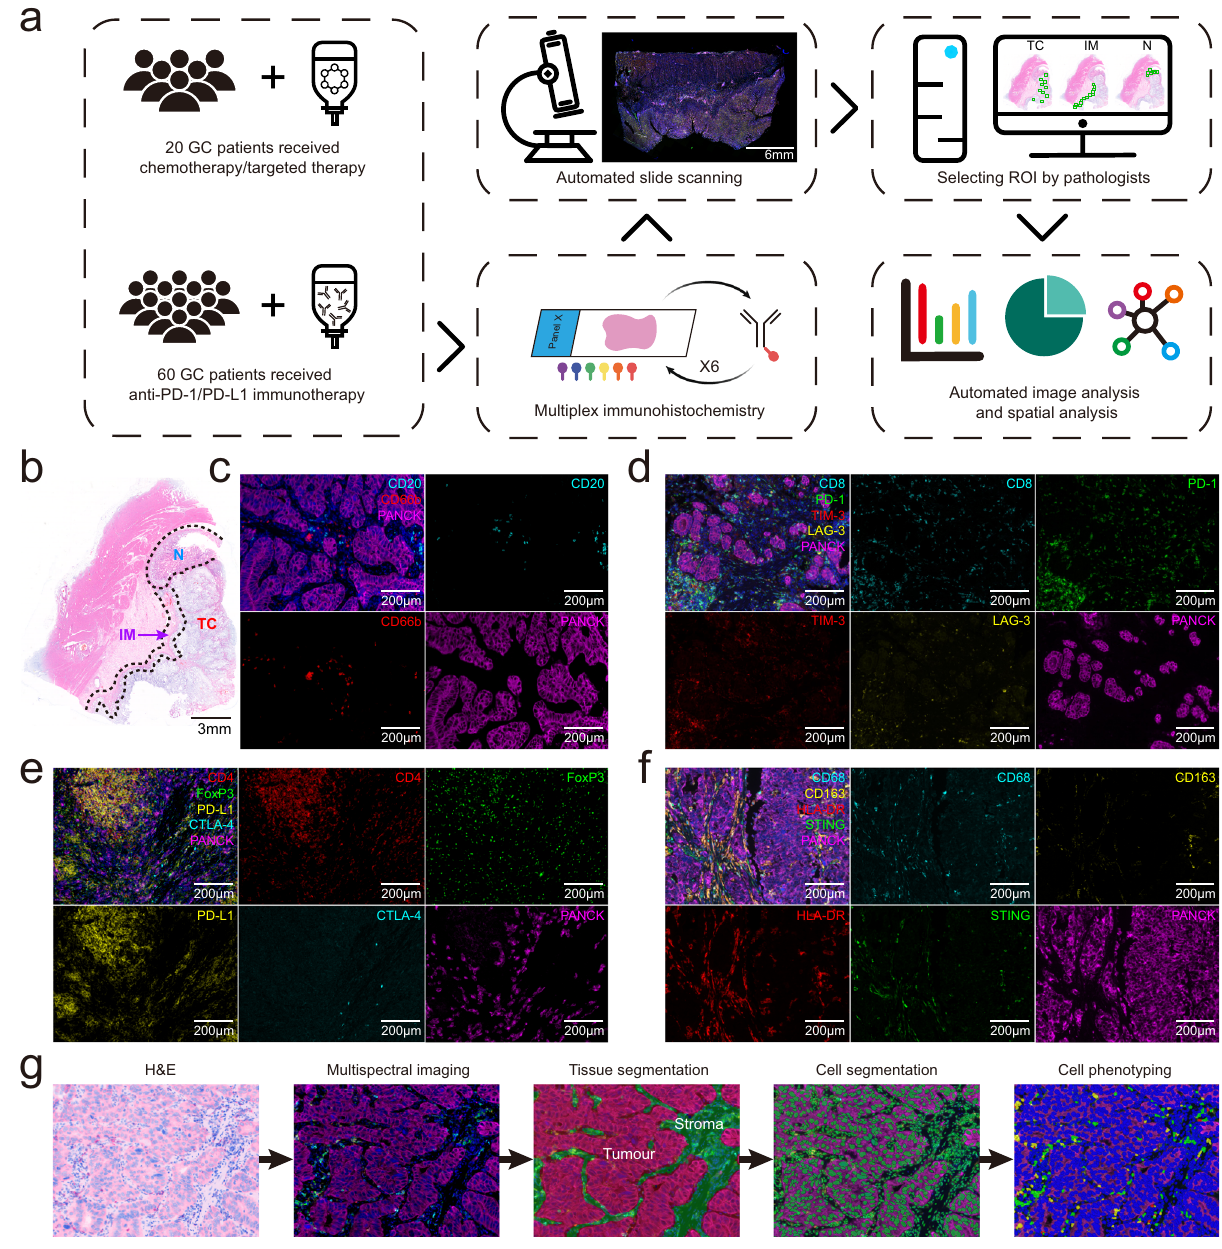
fi xed paraf fi n-embedded tissues. TC, tumour core; IM, invasion margin; N, normal tissue. Scale bar:3mm. c – f Representative composite and single-stainedimages of themultipleximmunohistochemistrypanelsused.Scalebar:200 µ m. g Overviewof the automated image analysis